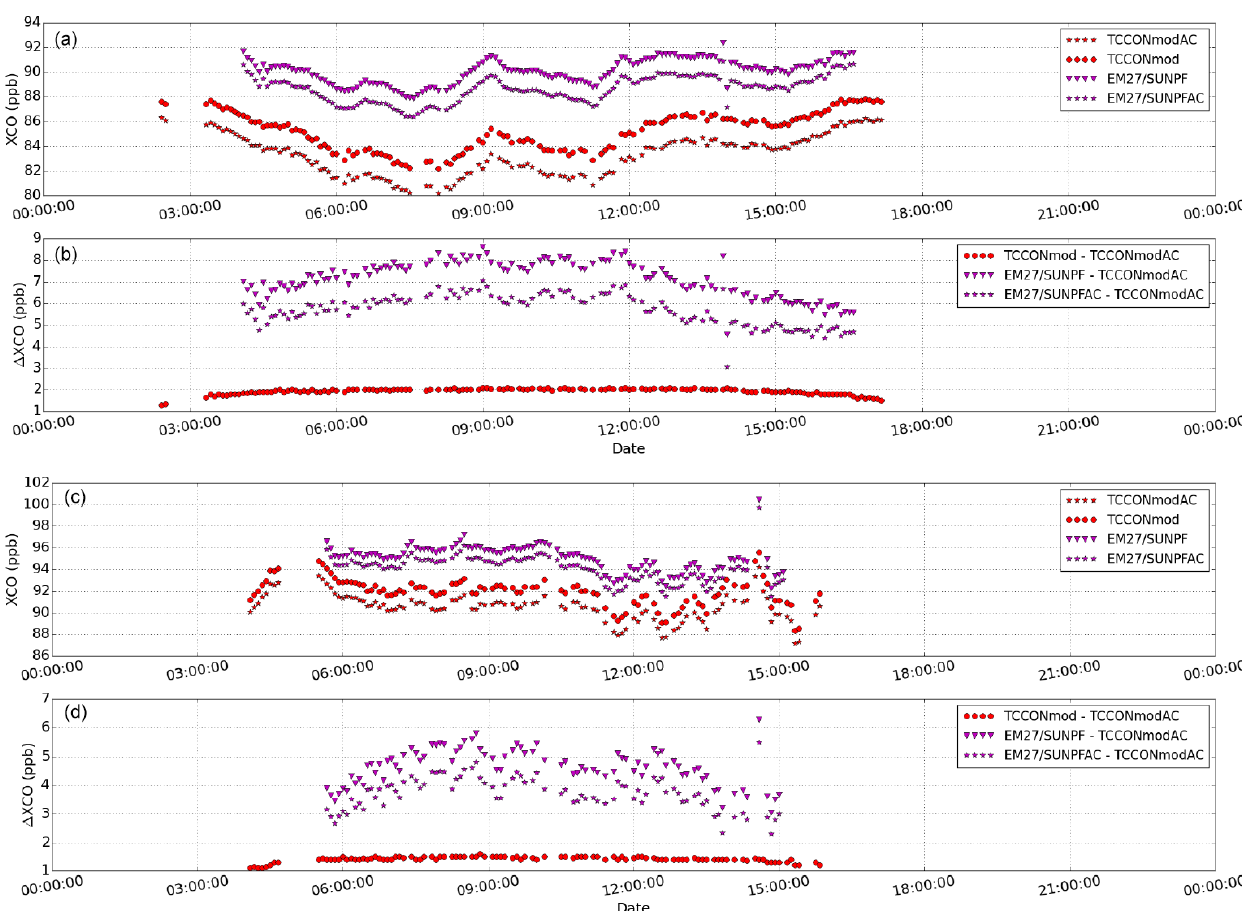
Figure 6. (a) XCO plotted for TCCONmod and EM27/SUN retrievals with the TCCON a priori and with a modified a priori (calculated using in situ, AirCore, and TCCON map files; labelled with AC at the end) for measurements performed on 15 May 2017 at Sodankylä. Panel (b) shows the difference between the two retrievals in absolute units. Panels (c) and (d) show the same plots as mentioned above for measurements performed on 28 August 2017 at